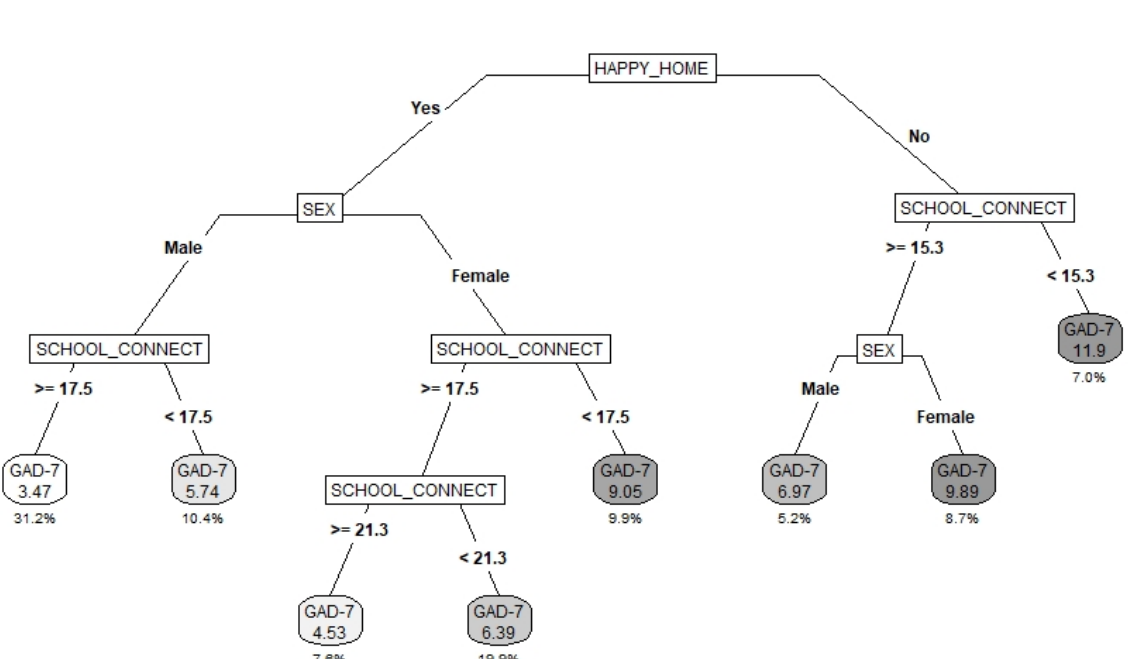
Figure 1. RE-EM Tree predicting average GAD-7 score for students participating in Year 7 (2018–2019) of the COMPASS Study ( N = 71.736). The GAD-7 score represents the average scale score within the subgroup. The percentage below represents the total percentage of the sample comprised by the subgroup.